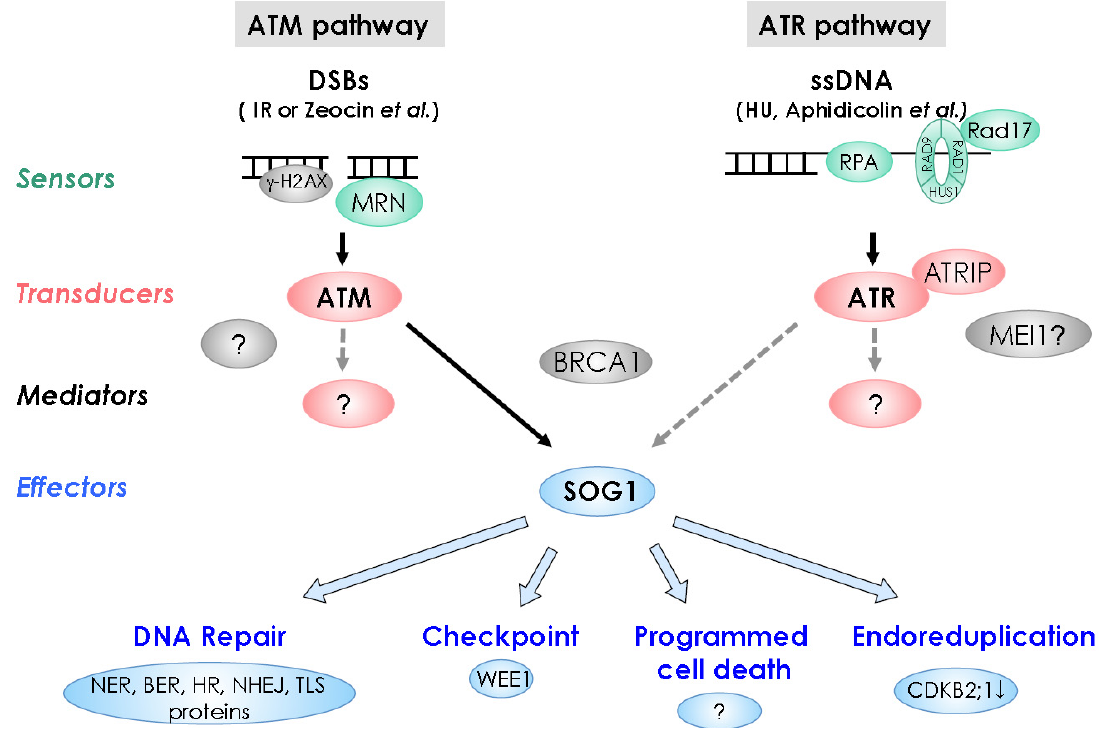
Figure 2. DNA damage response pathways in plants. DNA damage signal through the sensors shown in green, signal transducing kinases shown in red, mediators shown in gray, and effectors shown in blue, leading to DNA repair, cell-cycle checkpoint, programmed cell death, and endoreduplication. Dashed lines denote hypothetical